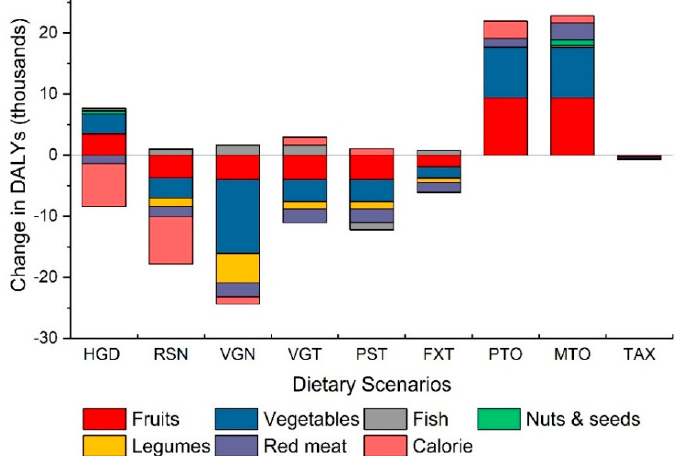
Figure 2. The modelled health impact associated with six dietary factors and the weight related factors (overweight & obesity combined shown as calories) are shown for all nine alternative scenarios. Negative numbers indicate human health benefit and positive numbers indicate an increase in adverse health outcomes.